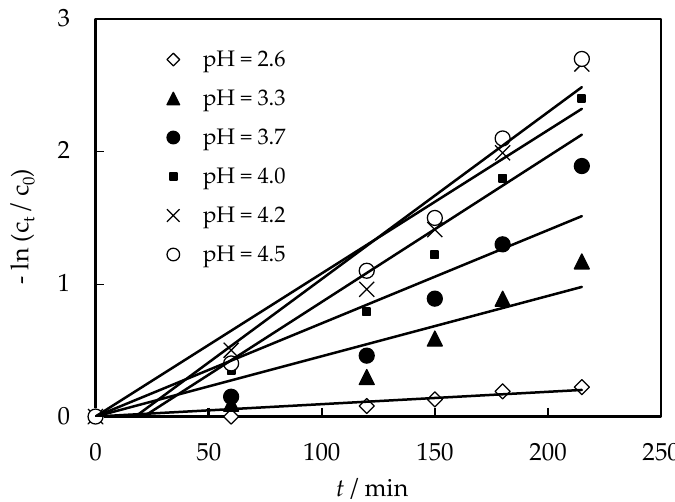
Figure 2. Effects of pH of the feeding solution on the dislodging efficiency of Cr (VI).